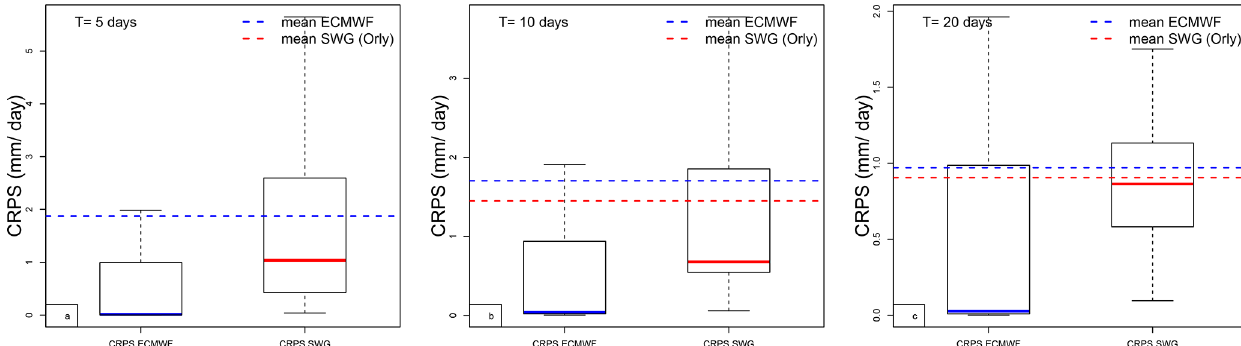
Figure C1. Boxplots of CRPS of ECMWF and CRPS of SWG for Orly, with lead time T = 5, 10, and 20d. The boxplots indicate the median ( q 50 ) of the distribution (thick blue bar for ECMWF and red for SWG). The 25th ( q 25 ) and 75th ( q 75 ) quartiles are, respectively, the lower and upper segments of each boxes. The upper whisker is min { max (X),q 50 + 1 . 5 (q 75 − q 25 ) } . The average CRPS of the ECMWF and SWG forecasts are indicated with dashed horizontal lines. Note that the distribution is asymmetric as the median and the average are unequal. The average CRPS for the SWG forecast is lower than the average CRPS for the ECMWF forecast. The outliers that are above the upper whiskers are not